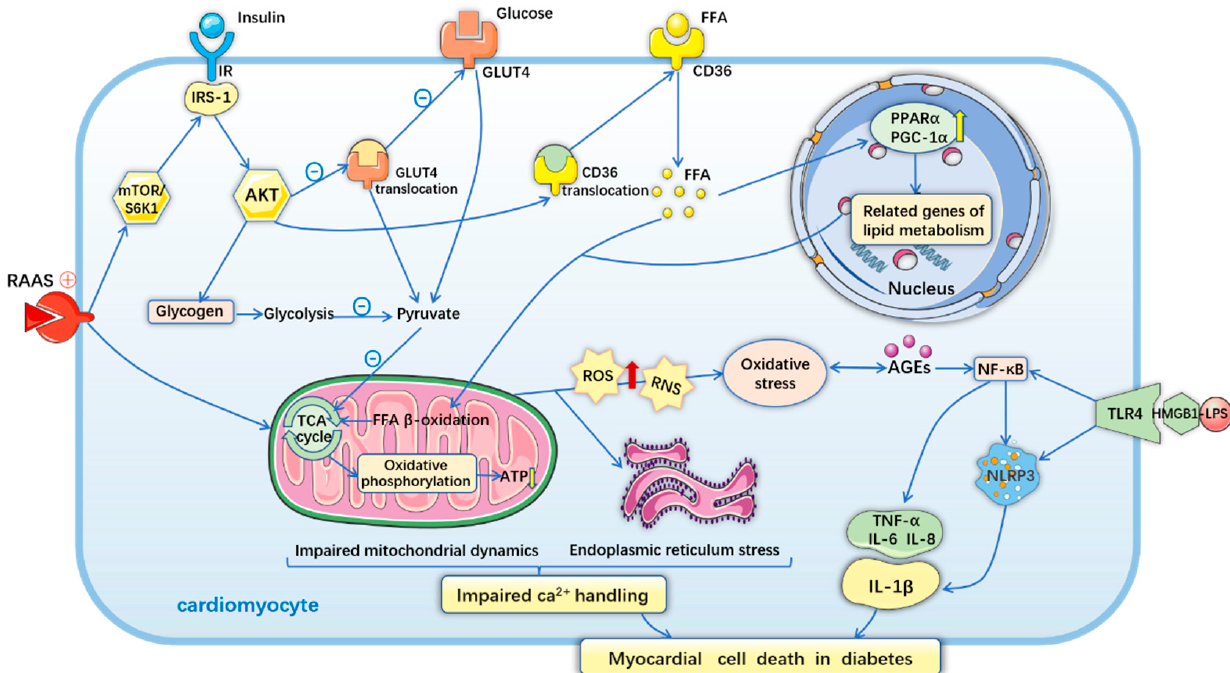
Figure 2. Mechanism of diabetes-induced myocardial cell death in diabetes. Hyperglycemia, hyperinsulinemia and insulin resistance, activation of the renin– angiotensin–aldosterone system, and mobilization of free fatty acids all can prompt mi- tochondrial dysfunction, oxidative stress, and endoplasmic reticulum stress. More free fatty acid uptake and oxidation increase the expression of cardiac PPAR α and PGC-1 α , and then aggravate the reduction of the production of ATP in mitochondria. These cyto- pathic effects result in intracellular impaired Ca 2+ handling and Ca 2+ sensitization increase, further cardiomyocyte death. The systemic glucotoxicity, lipotoxicity, and upregulated angiotensin II production promote proinflammatory processes. HMGB1 binding to LPS in- creases NLRP3 inflammasome assembling and induces the expression of proinflammatory cytokines, mediating inflammation, and myocardial cell death. 4. Role of lncRNAs in Various Types of Cardiomyocyte Death in DCM Evidence suggests that various types of cardiomyocyte death simultaneously act as terminal pathways in DCM and eventually accelerate the development of structural and functional impairment in HF, including apoptosis, autophagic cell death, pyroptosis, ferroptosis, and necroptosis. Until now, the suppression of any form of cardiomyocyte death has had a protective function in DCM; however, the regulatory mechanisms of cell death remain unclear and require further clarification. In addition, lncRNAs have been reported to participate in diabetes-induced cardiomyocyte death (Figure